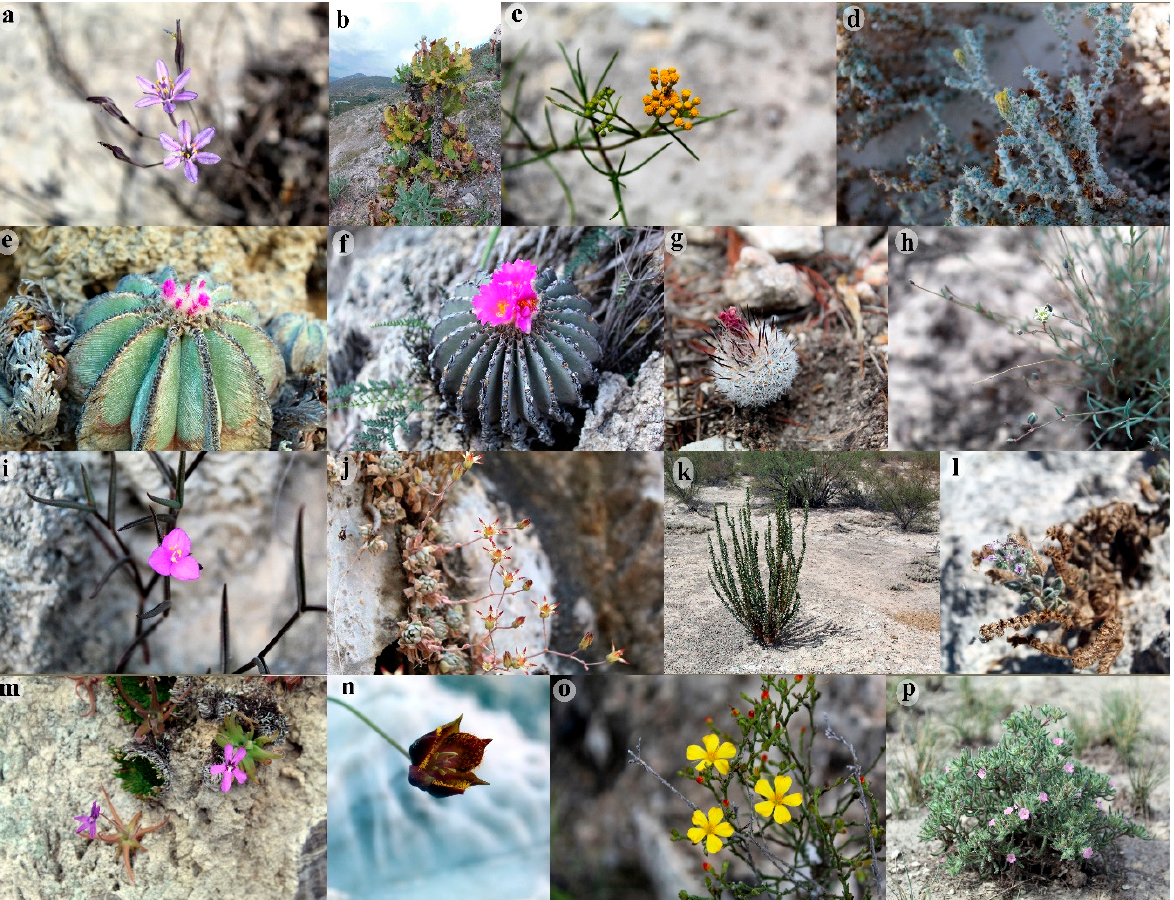
Figure 6. Examples of gypsophytes of Mexico. Asparagaceae: ( a ) Jaimehintonia gypsophila B.L. Turner; Asteraceae: ( b ) Mixtecalia teitaensis Redonda-Mart., García-Mend. and D. Sandoval, ( c ) Sartwellia mexicana A. Gray, ( d ) Xanthisma restiforme (B.L. Turner) D.R. Morgan and R.L. Hartm.; Cactaceae: ( e ) Aztekium hintonii Glass and Fitz Maurice, ( f ) Geohintonia mexicana Glass and Fitz Maurice, ( g ) Rapicactus booleanus (G.S.Hinton) D.Donati; Caryophyllaceae: ( h ) Drymaria lyropetala I.M. Johnst.; Commmelinaceae: ( i ) Callisia hintoniorum B.L. Turner; Crassulaceae: ( j ) Graptopetalum glassii Acev.-Rosas and Cházaro; Fouquieriaceae: ( k ) Fouquieria shrevei I.M. Johnst.; Hydrophyllaceae: ( l ) Phacelia marshall-johnstonii N.D. Atwood and Pinkava; Lentibulariaceae: ( m ) Pinguicula gypsicola Brandegee; Liliaceae: ( n ) Calochortus marcellae G.L. Nesom; Linaceae: ( o ) Linum macradenium Bran- degee; Namaceae: ( p ) Nama stevensii C.L. Hitchc. Photographs: ( a , c – p ) by J. P. Ortiz-Brunel, ( b )